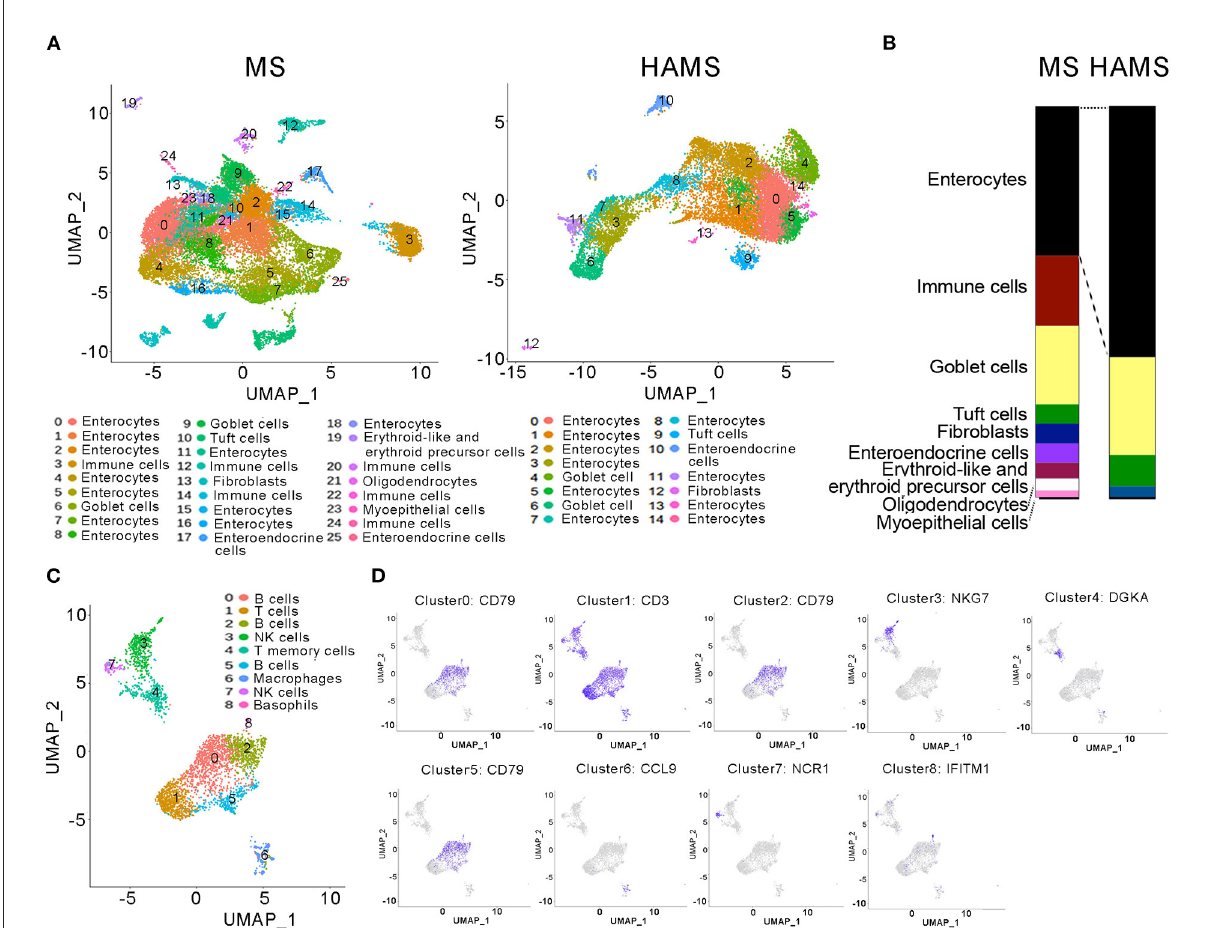
FIGURE3 Single-cell RNA sequencing of colon tissues. (A) UMAP analyses of colon tissues ( n = 3 biologically independent HAMS animals vs. n = 3MS animals) from the HAMS group and MS group are shown. Each color represents cells with a different subidentity. (B) The proportions of different cell types in the colon tissues of mice in the HAMS group and MS group. (C) UMAP analyses of immune cells in the MS group. Each color represents cells with a different subidentity. (D) UMAP analyses of marker genes in the MS